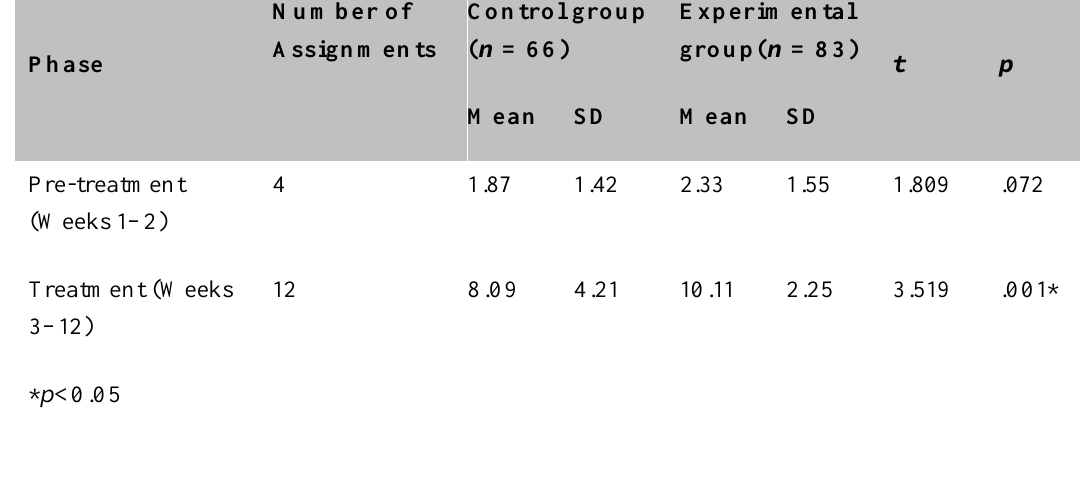
Descriptive Statistics and T-Test Results for the Number of Submitted Assignments